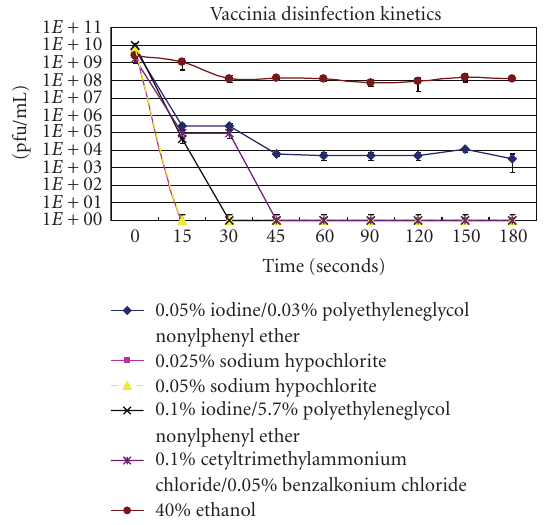
Figure 2: The inactivation kinetics of fowlpox virus following treatments with low concentrations of four di ff erent